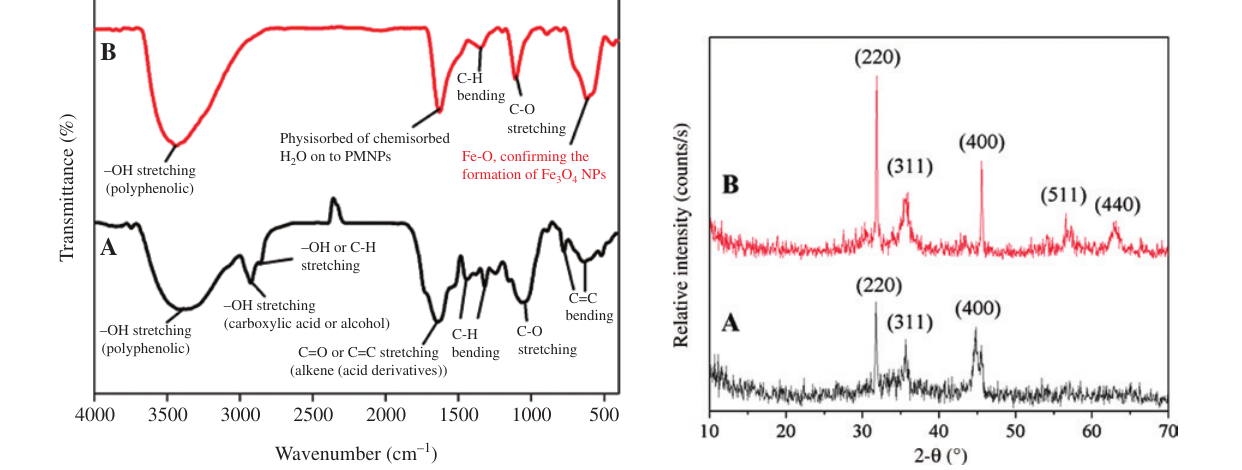
Figure 4: The powder X-ray diffraction (XRD) patterns of (A) CSMNPs and (B) the phytogenic magnetic nanoparticles (PMNPs). Reproduced from Ali et al. (2018) with permission from Royal Society of Chemistry,